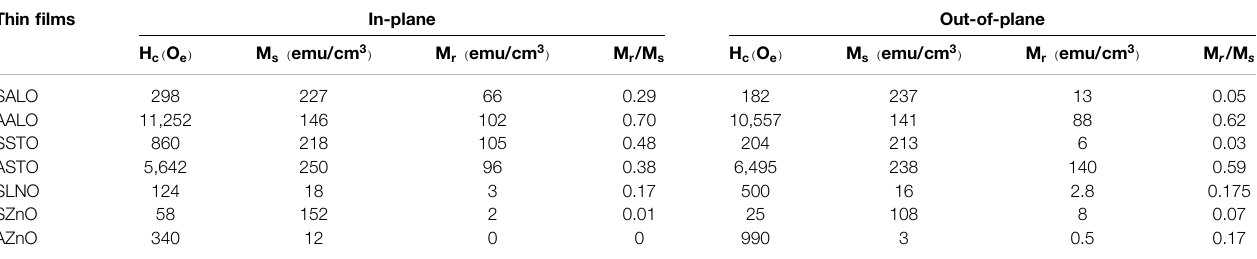
TABLE 2 | Magnetic characteristics of the SrM fi lms grown on different substrates in an applied magnetic fi eld, parallel to (in-plane) or perpendicular to (out-of-plane) the c-axis of SrM. Thin fi lms In-plane